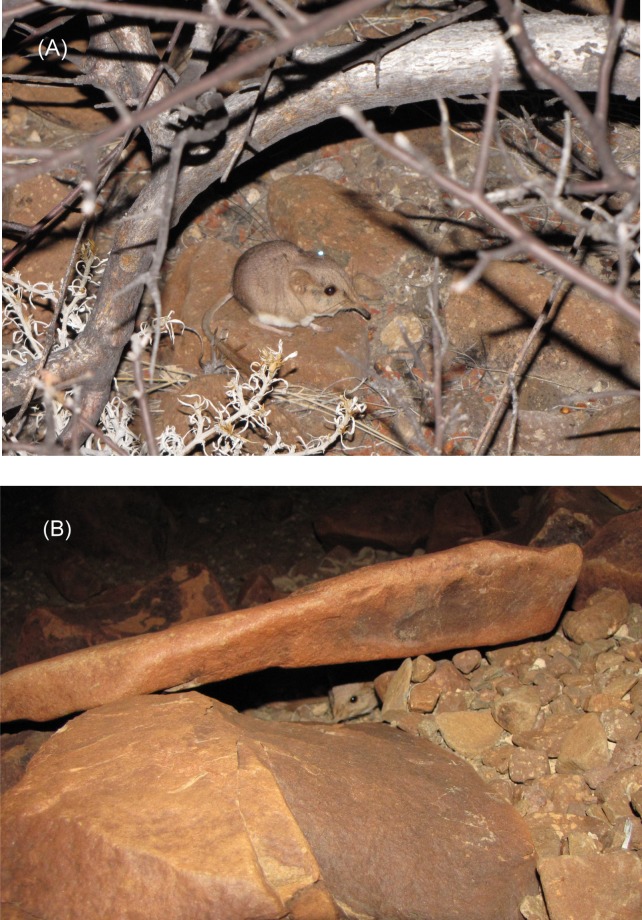
Ear-tagged and radio-collared M. micus at study site in Goboboseb Mountains, Namibia.(A) Sengi #4856F under Commiphora bush on 22 Oct 2014 at 2342 h. Visible are the reflective tag on left ear and transmitter antenna extending from top of neck over back. Radio collar is completely hidden by fur. (B) Sengi #4947M at the opening of a typical rock shelter on 25 Oct 2014 at 2351 h. Photos by GBR.